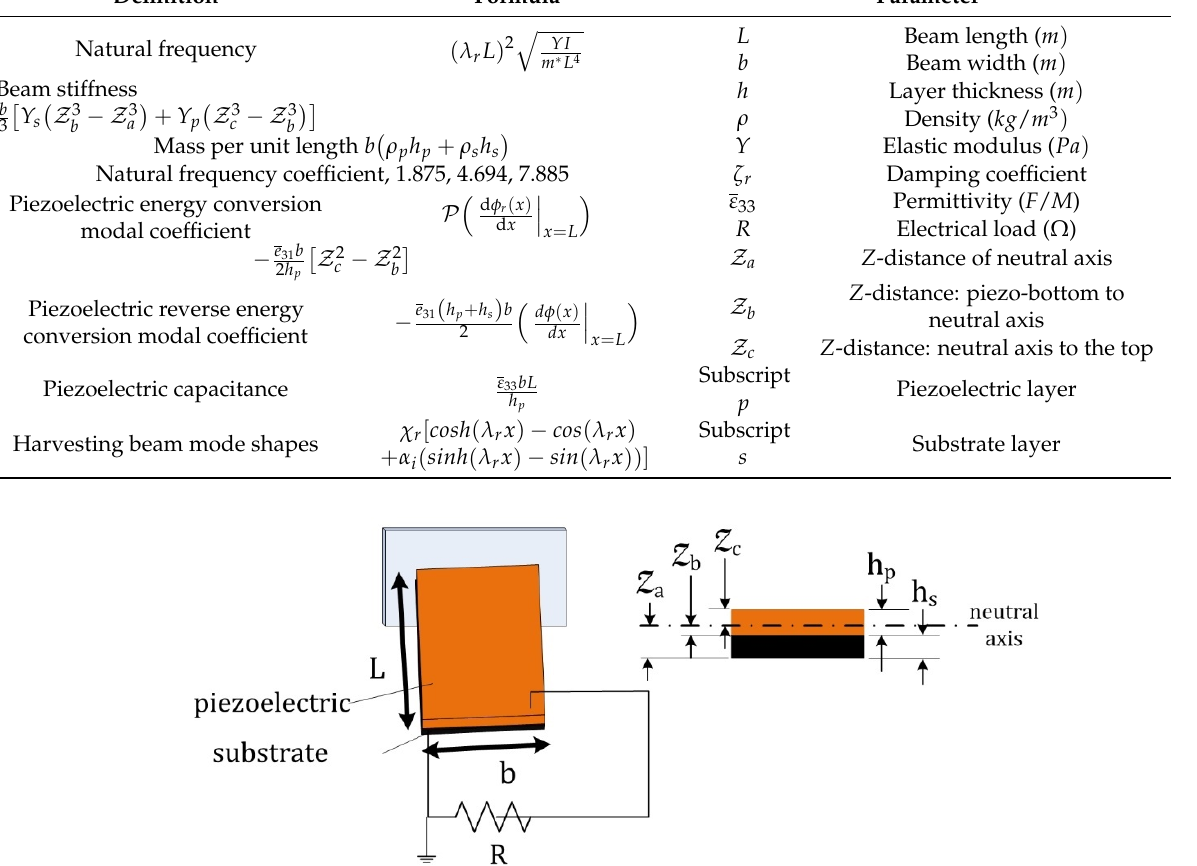
Figure 2. Piezoelectric sample with dimensions.